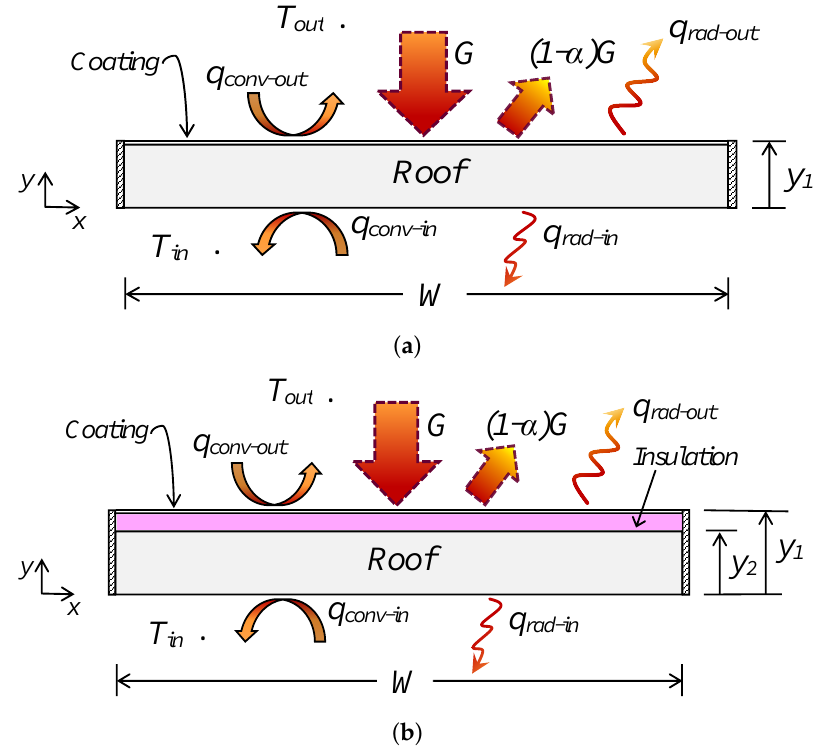
Figure 1. Physical model. ( a ) Single roof; ( b ) Insulated roof.